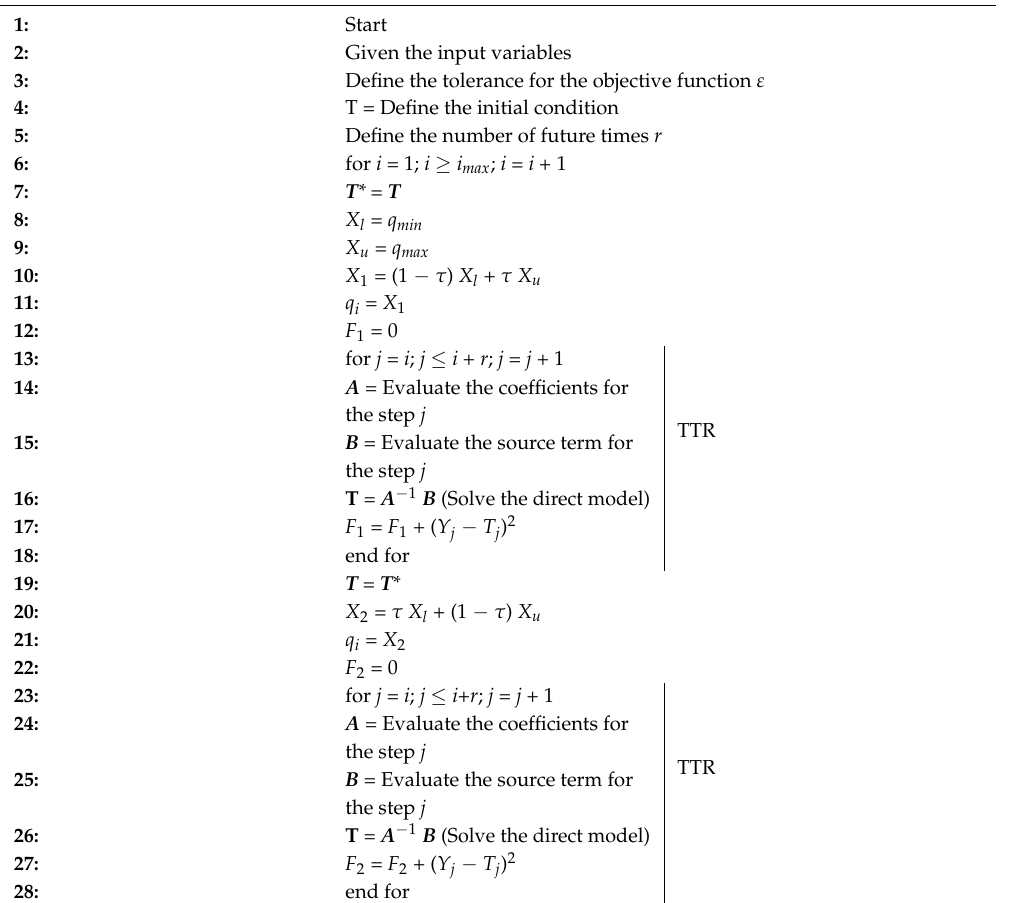
Algorithm 1: The Golden Section Algorithm with Time Travelling